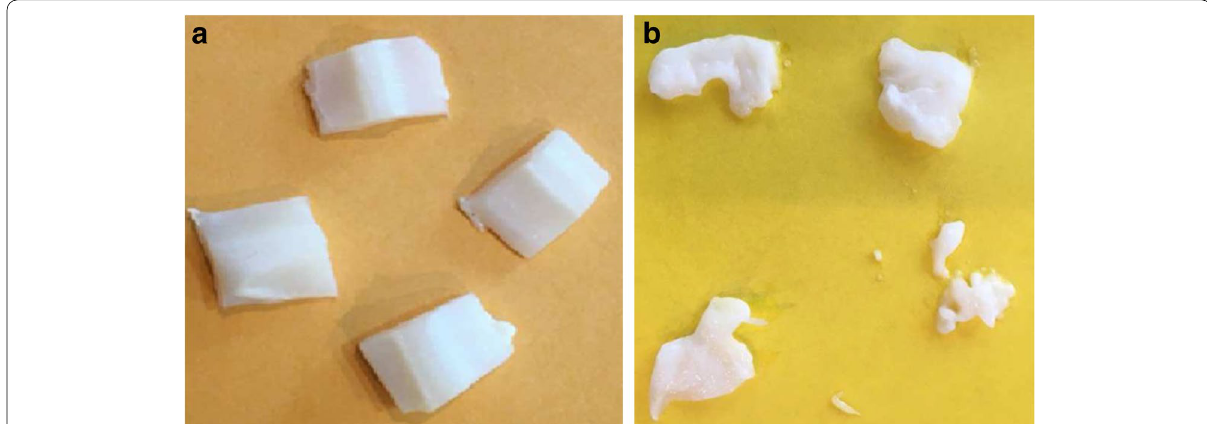
Fig. 1 a Pieces of cartilage treated with normal saline at 4°C for 10 days. b Pieces of cartilage treated with papain in normal saline at 4°C for 10